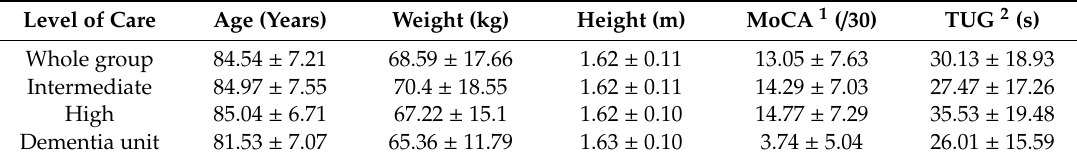
Table 1. Participant demographic information, cognition, and mobility